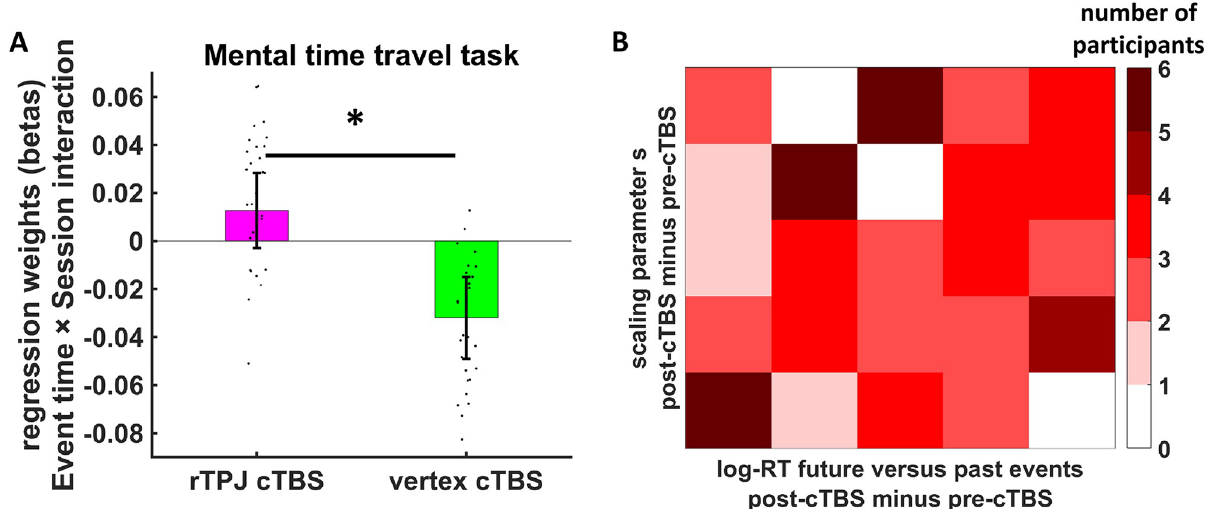
Fig 3. Effects of rTPJ cTBS on mental time traveling. (A) rTPJ, relative to vertex, cTBS, increased the post-cTBS minus pre-cTBS difference in RT (log-RT) for judging future relative to past events. Error bars indicate standard error of the mean. Black dots show individual parameter estimates (based on random effects estimates). Asterisks indicate significant effects ( p < 0.05). (B) Heatmap illustrating the correlation between cTBS-induced post-cTBS minus pre-cTBS changes in the mental time-travel task (binned log-RT difference between events in the relative future and relative past) and the intertemporal choice task (binned scaling parameter s from generalized hyperbolic discounting). Darker colors indicate a higher number of participants in a given cell. Note that the darker colors locate primarily around the diagonal, illustrating the correlation between the cTBS effects in the two tasks. The underlying data for this Figure can be found in S1 Data. CHF, Swiss francs; cTBS, continuous theta-burst stimulation; fMRI, functional magnetic resonance imaging; RT, response time; rTPJ, right temporoparietal junction.